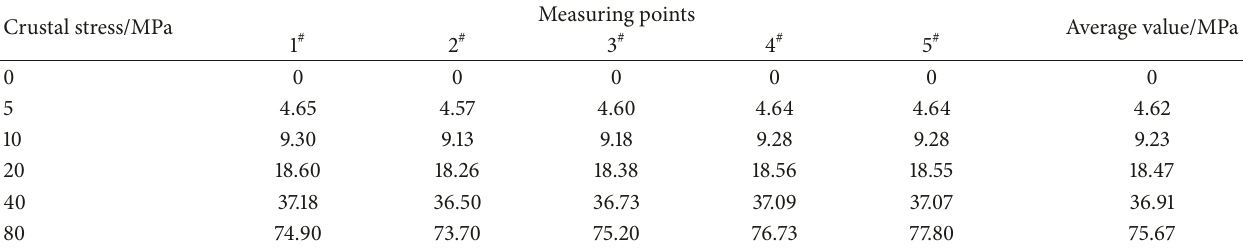
Table 5: Stress values of 𝑍 direction of the same measuring points under different crustal stress. Crustal stress/MPa